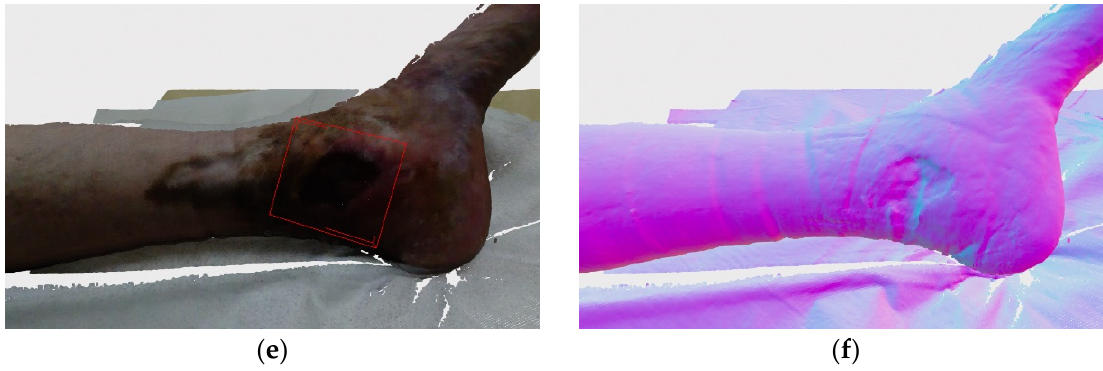
Figure 17. Hospital Recording of venous ulcer 1: ( a ) wound detection at initial recording position; ( b ) recording poses relative to the recorded wound; ( c ) robot position in relation to the recorded wound in first recording; ( d ) robot position in relation to the recorded wound in second recording; ( e ) final 3D model; ( f ) final 3D model with normal map rendering.